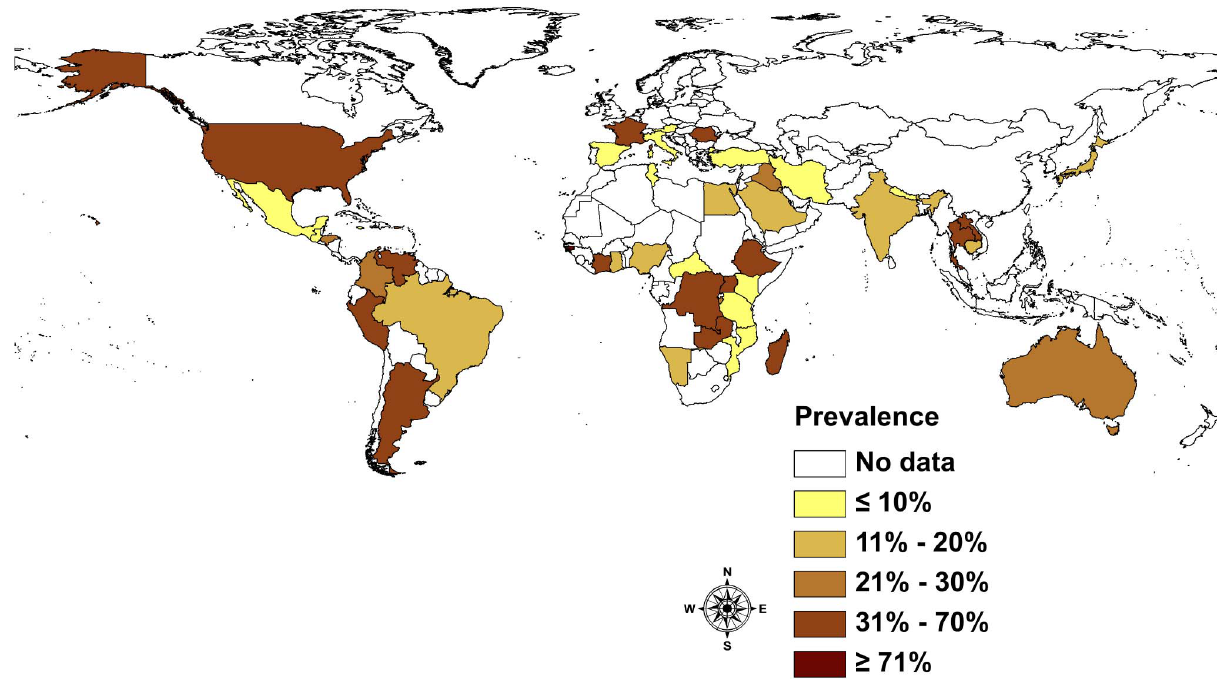
Figure 5. Prevalence of S.stercoralis infection by country based on health services studies.